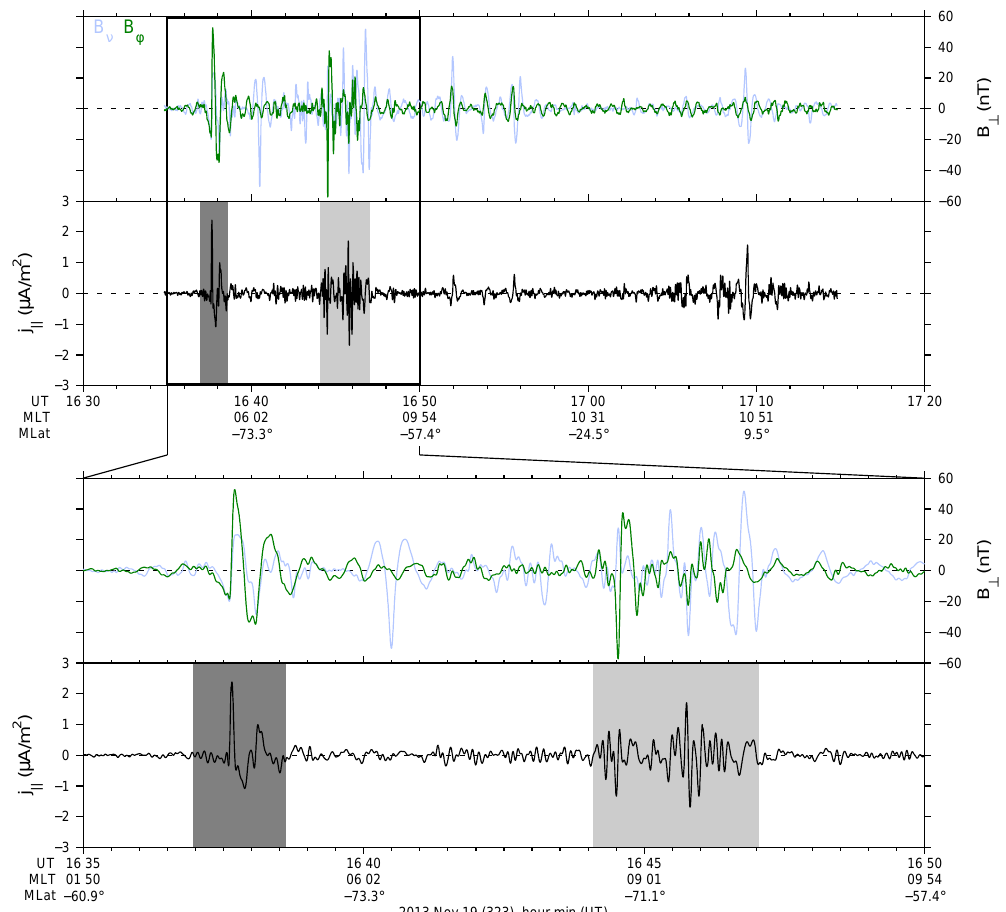
Figure 7. Perpendicular components of the magnetic field (radial in blue, azimuthal in green) and calculated field-aligned currents.